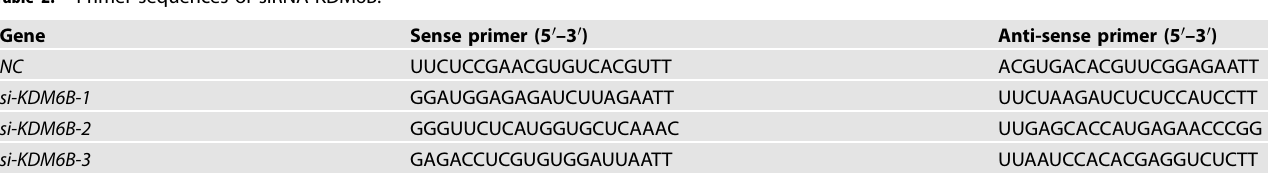
Table 2. Primer sequences of siRNA-KDM6B. Gene